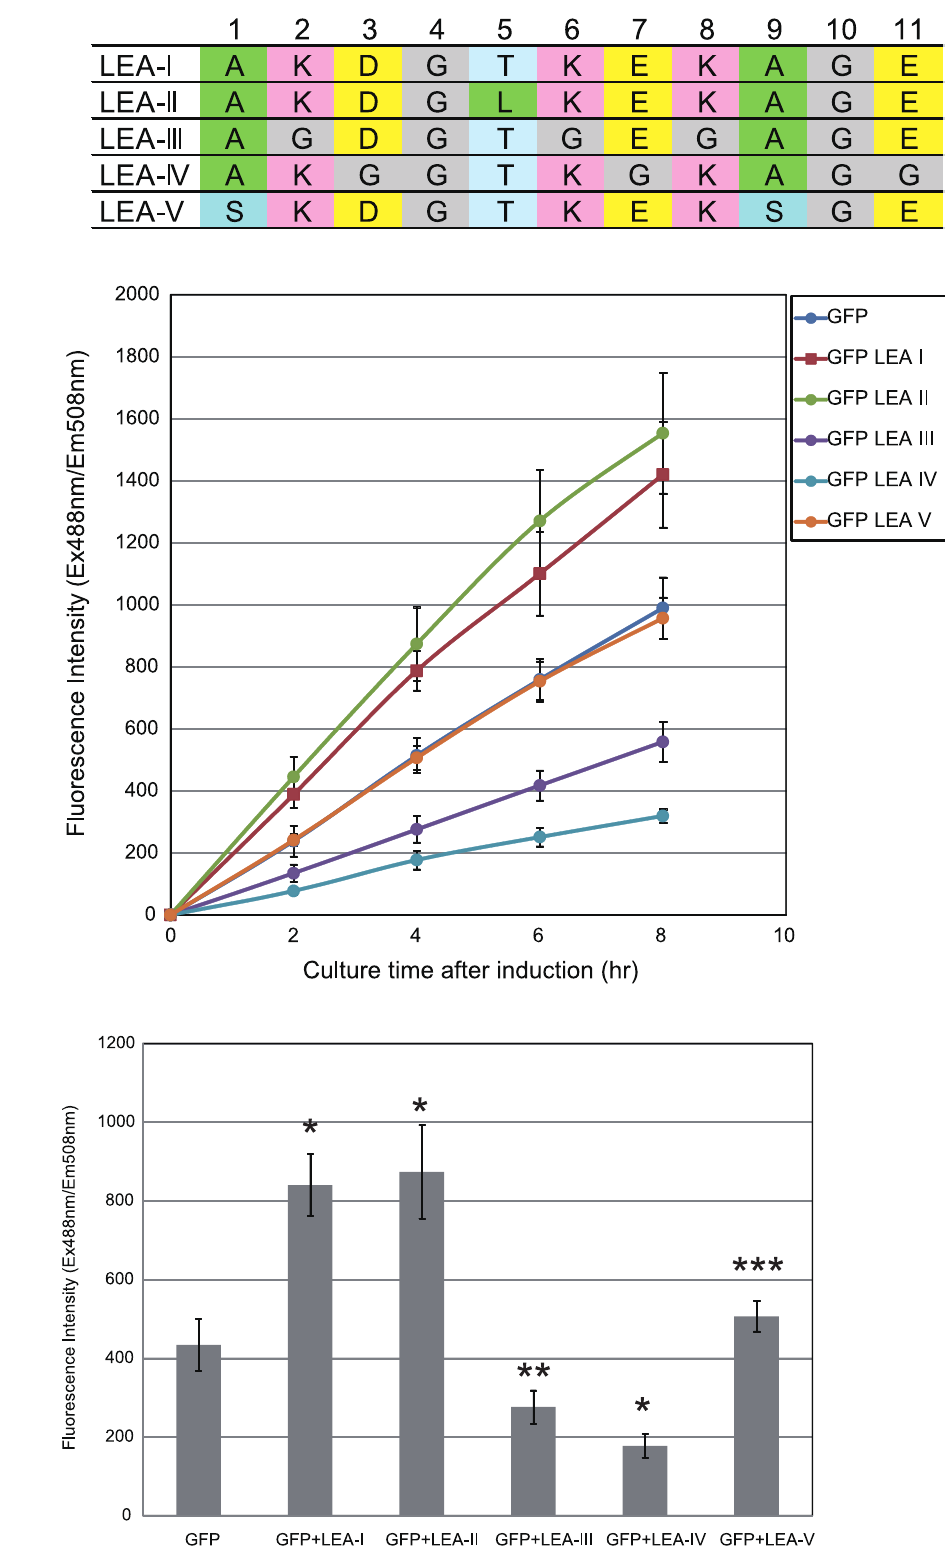
Figure 3. GFP expression with co-expression of each LEA-like peptide. (a) The designed sequence of each LEA-like peptide (b) Time dependence of GFP expression with co-expression of each LEA-like peptide (c) GFP expression with co-expression of each LEA-like peptide 4 h after induction. Data are expressed as mean 6 s.d. (n=5). Results with * P , 0.0001 and ** P , 0.005, shown above the bar were significantly different from those for GFP alone (two-side t -test). *** did not show significant difference from GFP alone (two-side t-test). Each P value is LEA-I: 0.0000214, LEA-II: 0.0000897, LEA-III: 0.0020771, LEA-IV: 0.0000486, and LEA-V: 0.8133212, respectively. doi:10.1371/journal.pone.0082824.g003 PLOS ONE |